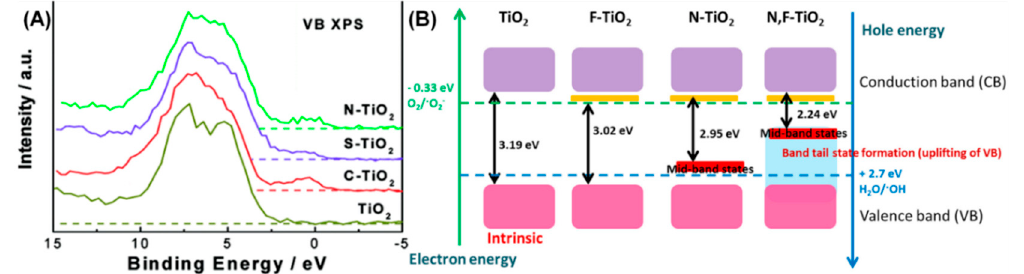
Figure 3. ( A ) Valence band (VB) XPS spectra of pure and (C, S, N)-doped TiO 2 ; ( B ) proposed band gap engineering structure for all (F, N) doped TiO 2 (reproduced with permission from refs. [56,57], respectively).